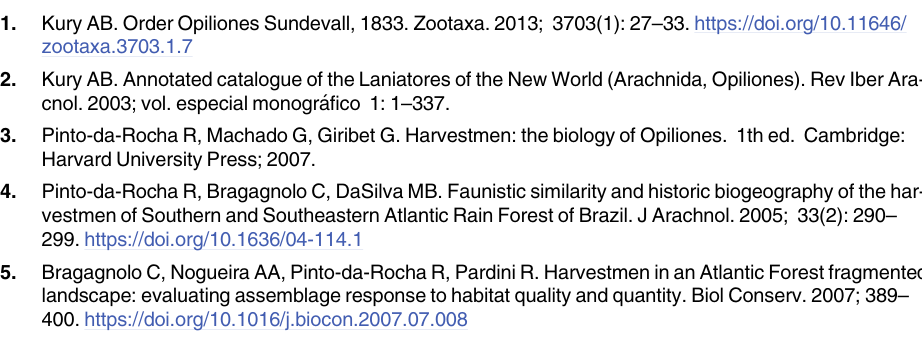
S15 Table. Pairwise F values between N . robustus populations obtained for COI ST sequences ( � p < 0.05). S16 Table. Pairwise F values between N . robustus populations obtained for ITS2 ST sequences ( � p <